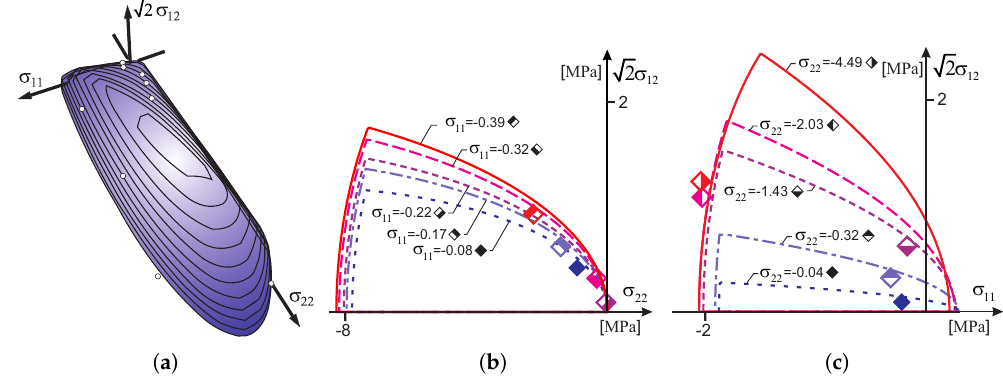
Figure 5. Comparison of the proposed base contour of the failure surface with the experimental results of Ganz and Thürliman [36]: ( a ) 3D view, ( b ) by cross sections of the body with σ 22 = const , ( c ) by cross sections of the body with σ 11 = const .